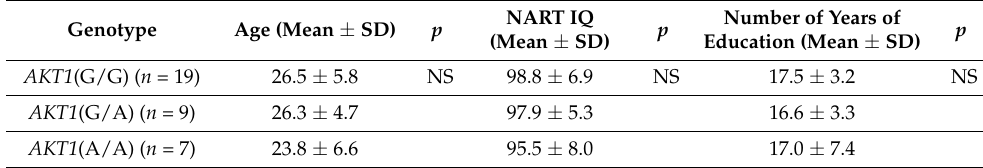
Table 2. Participants by genotype, average age, NART IQ and